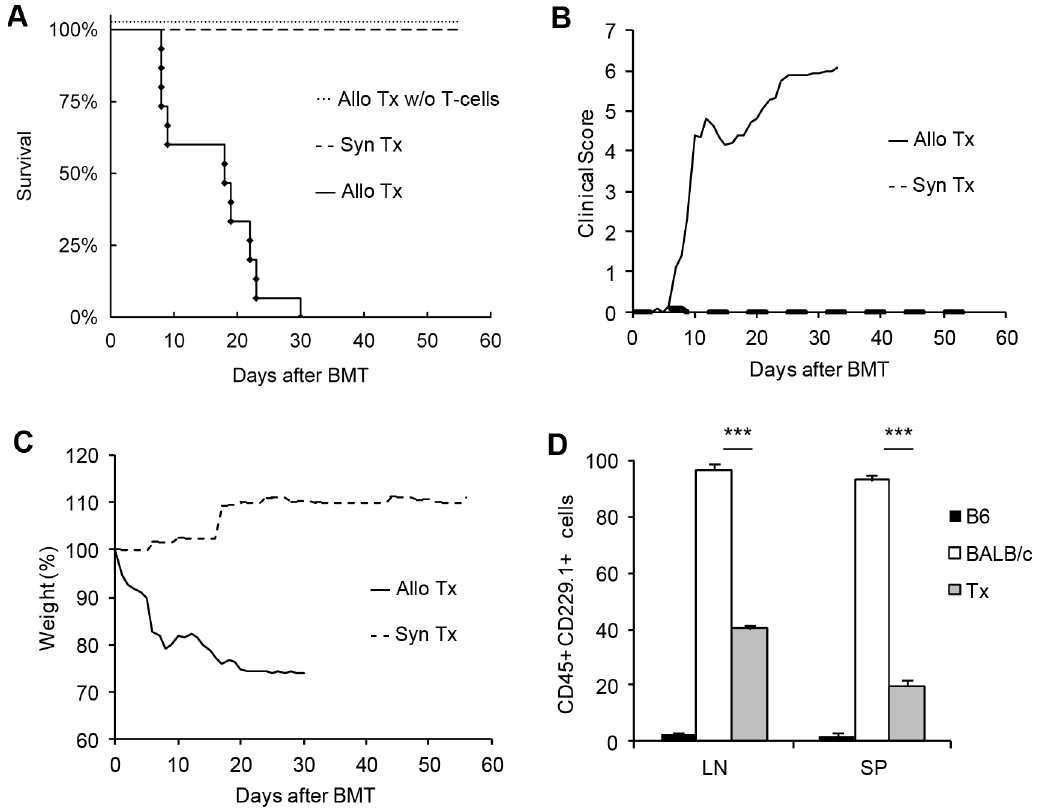
Figure 1. Major histocompatibility complex (MHC) mismatched mouse model of allogeneic BMT for GvHD induction. Survival after allogeneic BMT in a C57BL/6 (B6) R BALB/c mouse model (n=15) of acute GVHD ( — ¤ ) (A). Both, syngeneic BALB/c R BALB/c BMT (n=11) and allogeneic T-cell depleted B6 R BALB/c BMT (n=3) were performed as transplantation controls. Both control groups are represented as dashed lines with a survival rate of 100%. Daily assessed clinical score of allogeneic (including T-cells) vs. syngeneic transplanted mice (B). Weight changes in allogeneic (including T-cells) vs. syngeneic transplanted mice (C). Assessment of engraftment by cellular chimerism analysis 56 days after BMT in the T-cell depleted B6 R BALB/c mouse model (D). CD45 positive leukocytes were stained for expression of CD229.1 antigen which is expressed on BALB/c leukocytes but not on B6 cells. Percentages of CD45 + CD229.1 + leukocytes from all splenocytes (SP) or lymph node cells (LN) are shown. Stainings were performed for wild-type B6 (black bars), wild-type BALB/c (white bars) and B6 R BALB/c transplanted mice (Tx, grey bars). Chimerism analysis was performed in 3 animals from each group (mean 6 SD, ***p , 0.001).